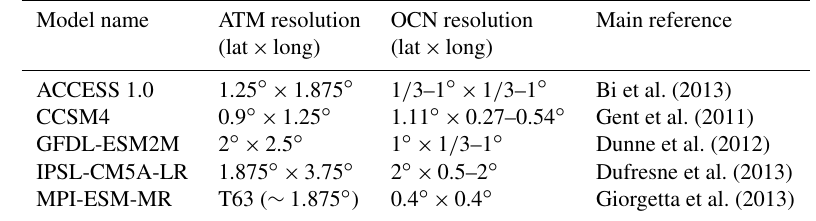
Table 3. Description of global climate models selected as lateral boundary forcings for MRCM simulation in the study.